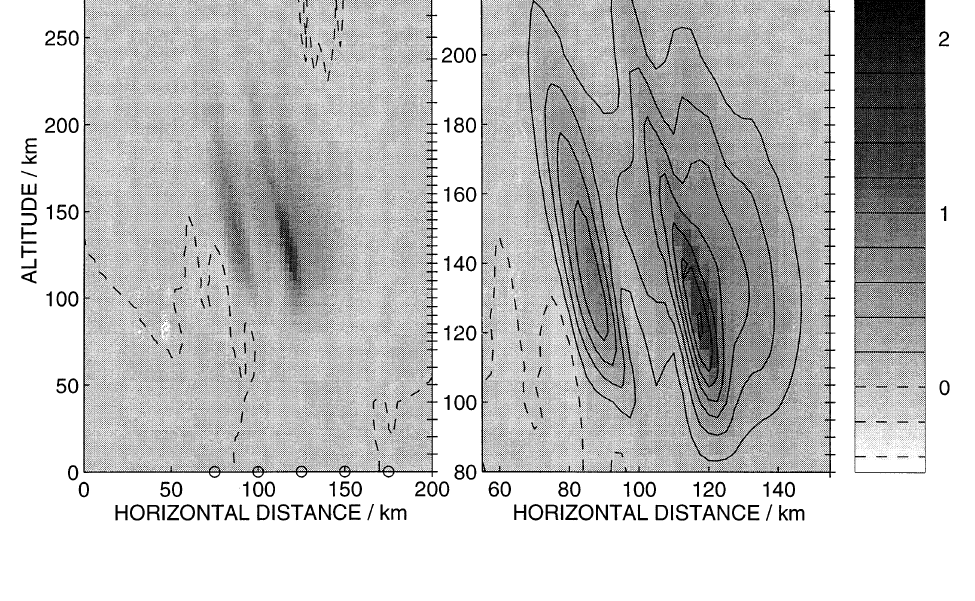
Fig. 8. Auroral intensity as a function of elevation angle as observed at Troms (cid:249) and Esrange at 1959:40 and 200:00 UT on 19 January 1993. The vertical axis is in arbitrary units and the observa- tions from the two sites are in different scales. The elevation angle is defined to be zero for northward horizontal direction and 180 ° southward horizontal direction in the vertical plane connecting the two